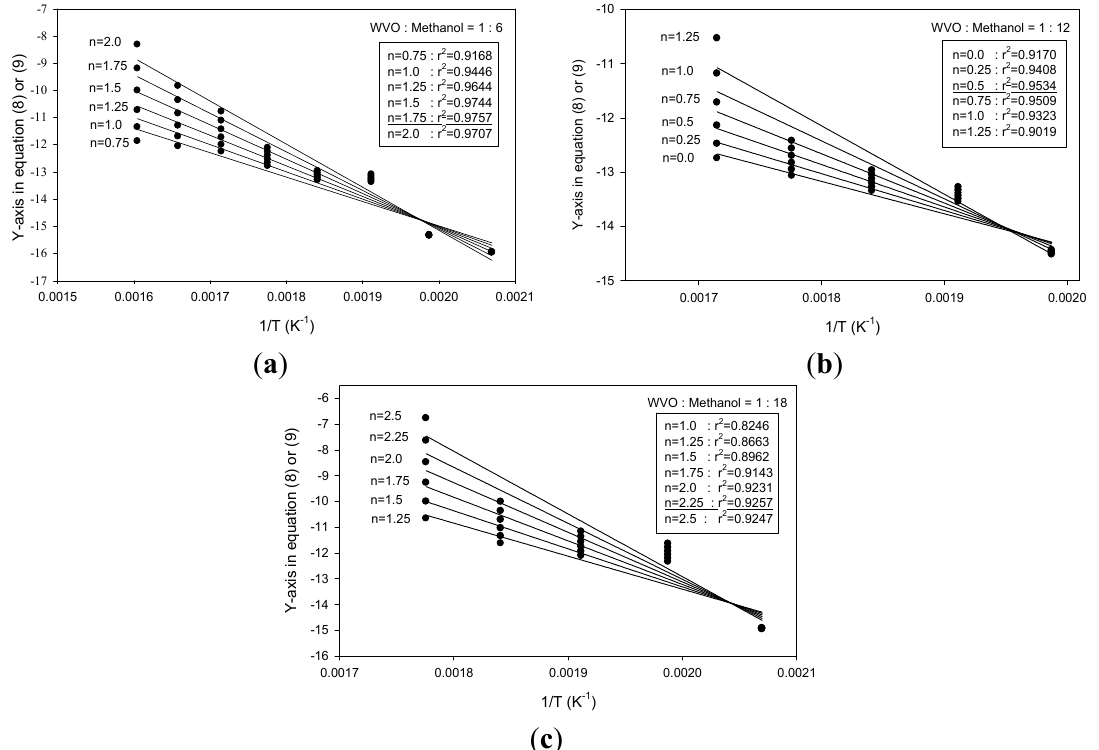
Figure 5. Application of the kinetic analysis method for SCM with WVO and methanol at molar ratios of: ( a ) 1:6; ( b ) 1:12; and ( c )